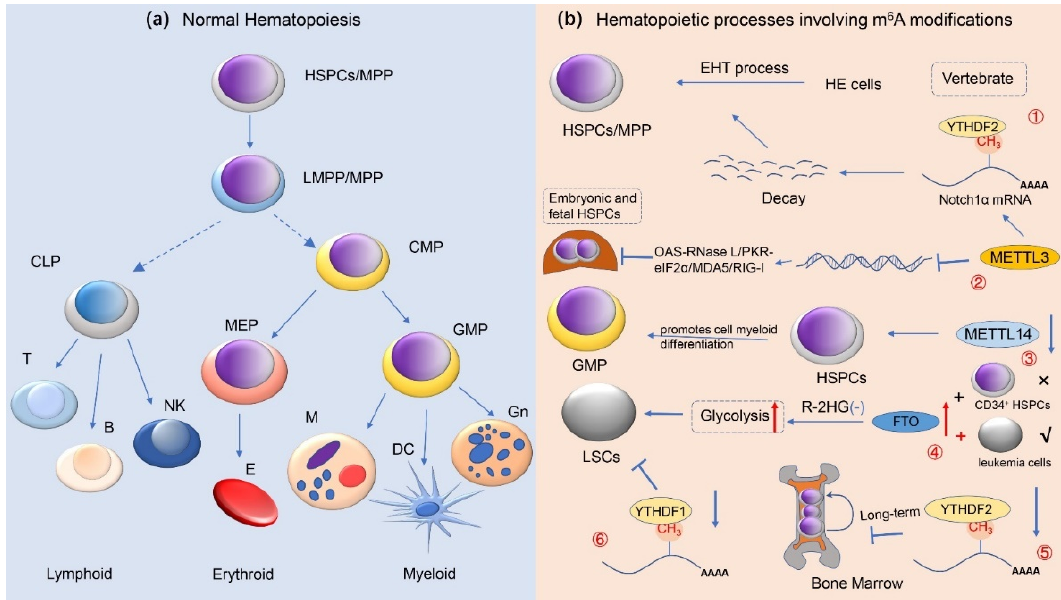
Figure 3. m 6 A methylation modifications and normal hematopoietic regulation. This image depicts the role of RNA m 6 A methylation in normal human hematopoiesis. ( a ) The development and dif- ferentiation process with respect to human normal hematopoietic stem/progenitor cells (HSPCs) is presented here, i.e., from HSPCs to terminally differentiated erythroid, lymphoid, and myeloid cells; ( b ) It has revealed that m 6 A modification modulates the normal hematopoietic system. ① METTL3- mediated m 6 A modifications regulate HSPC fate specification via suppressing Notch signaling dur- ing early definitive hematopoiesis. ② During the expansion of HSPC in the fetal liver, METTL3 deletion promotes the formation of dsRNA, activates the OAS RNase L and PKR-eIF2a pathways, and upregulates MDA5/RIG-I, resulting in hematopoietic failure. ③ METTL14 is highly expressed during the development of normal CD34 + HSPCs cells, and silencing METTL14 facilitates terminal myeloid differentiation of HSPCs cells. ④ In R-2HG-sensitive leukemic cells but not in normal CD34 + HSPCs, overexpression of FTO reverses the effect of R-2HG-induced glycolysis inhibition, leading to leukemogenesis in vivo. ⑤ Deficiency of YTHDF2 causes the failure of hematopoietic stem cells during serial transplantation and prolonged activation of pro-inflammatory pathways, ultimately contributing to progressive bone marrow bias. ⑥ YTHDC1 deletion impedes the prolif- eration and survival of LSCs in vivo, supporting the oncogenic role of YTHDC1 in leukemias (e.g., AML). Abbreviations: HSPCs hematopoietic stem/progenitor cells; MPP multipotent progenitors; LMPP lymphoid-primed multipotential progenitors; CMP common myeloid progenitor; CLP com- mon lymphoid progenitor; GMPs granulocyte/monocyte progenitor; MEPs megakaryo- cytes/erythroid progenitor; Gn granulocyte; DC dendritic cell; M monocyte; E erythrocyte; NK nat- ural killer cell; EHT endothelial-to-hematopoietic transition; LSCs leukemia stem cells; HE hemo- genic endothelial; R-2HG R-2-hydroxyglutarate.